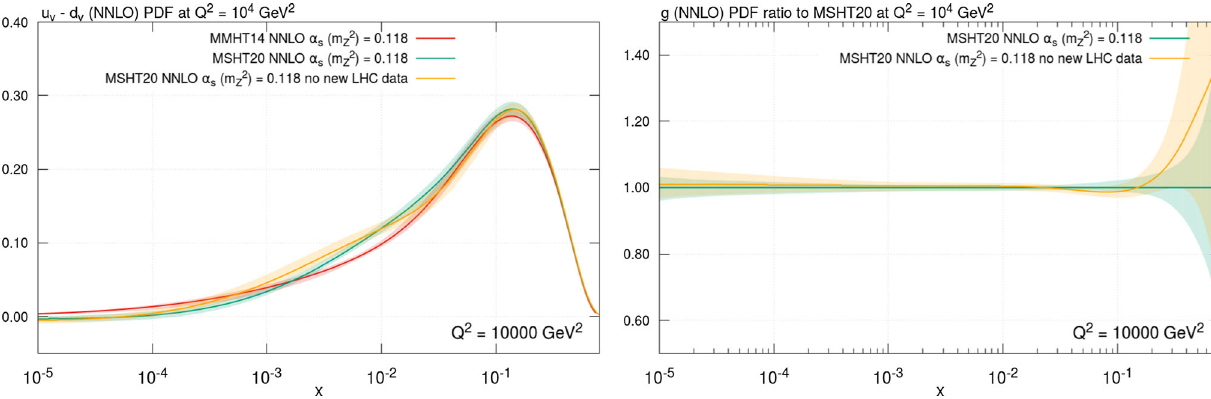
Fig. 50 (Left) u V − d V and (right) g PDFs comparing the MSHT20 default fit with the same upon removal of the new LHC data. The former plot presents the PDFs themselves and the latter plot presents the ratio to the MSHT20 default fit, both at NNLO at Q 2 = 10 4 GeV 2